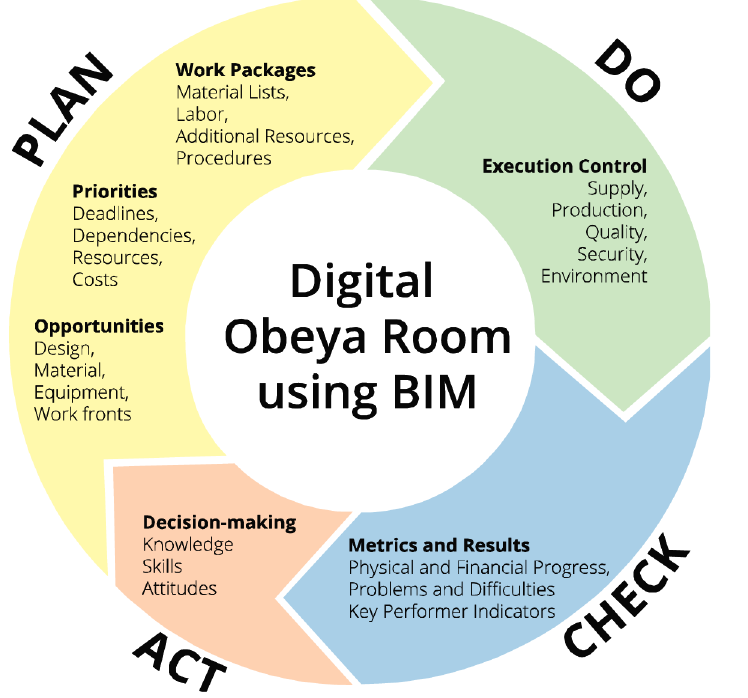
Fig. 2. Digital Obeya room – Information flow using the proposed